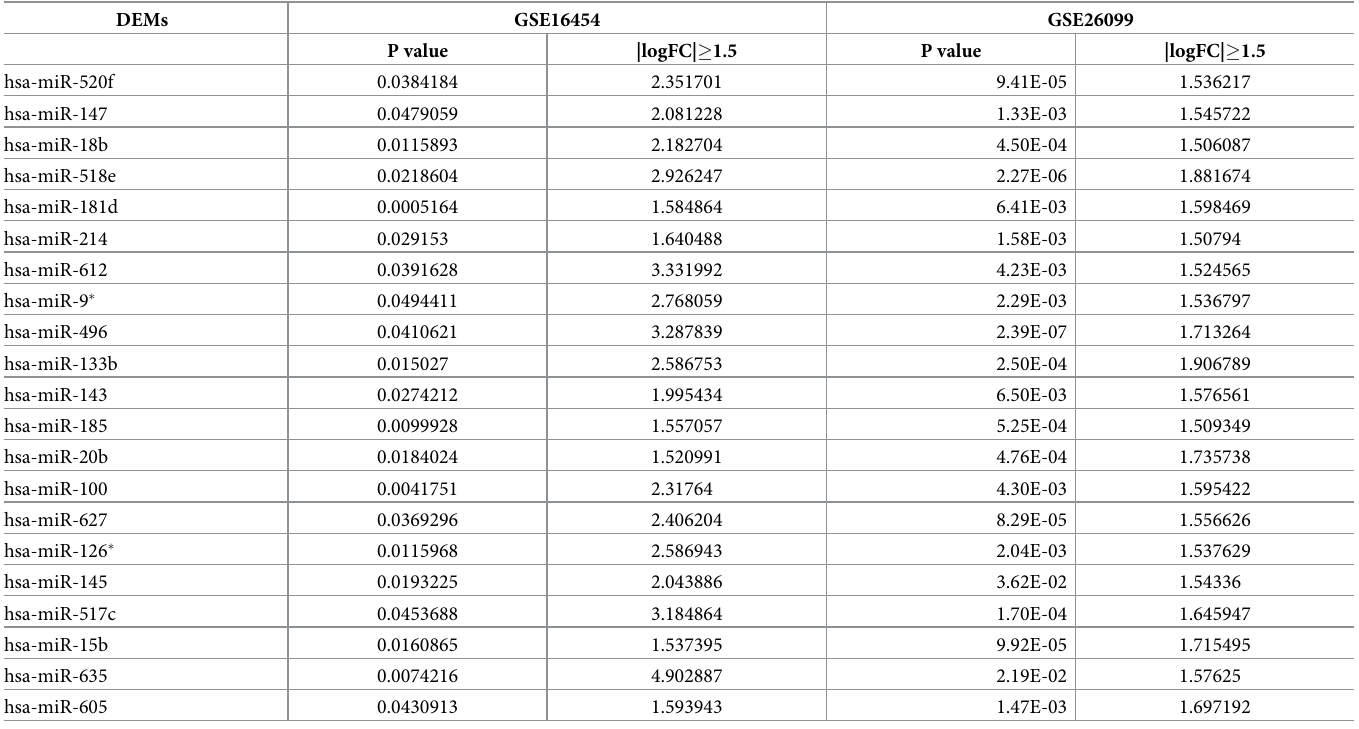
Table 1. The P value and |logFC| � 1.5 of significant